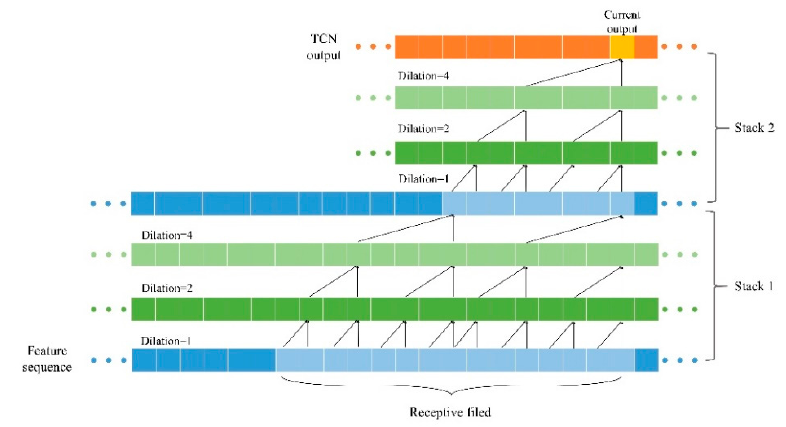
Figure 7. Simplified visualization of a TCN with kernel = 2, stack = 2, and dilation structure = [1, 2, 4].